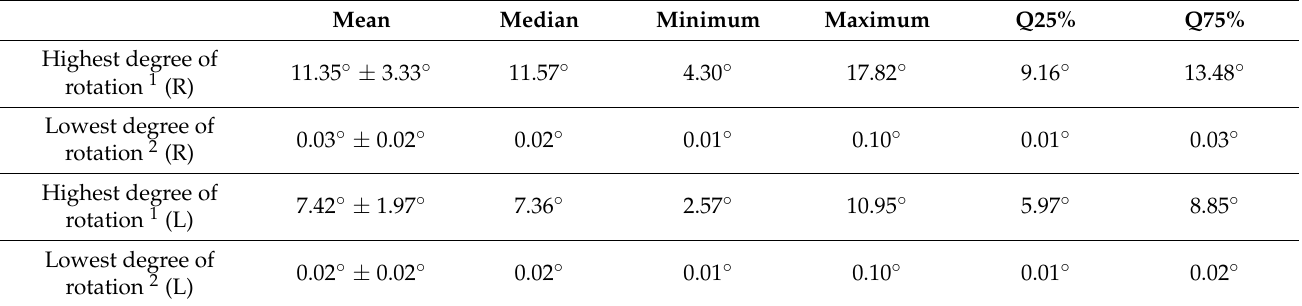
Table 3. The highest and lowest degree of rotation of the lumbar spine (L1–L5) measured with the dynamic spine-correction device (n =